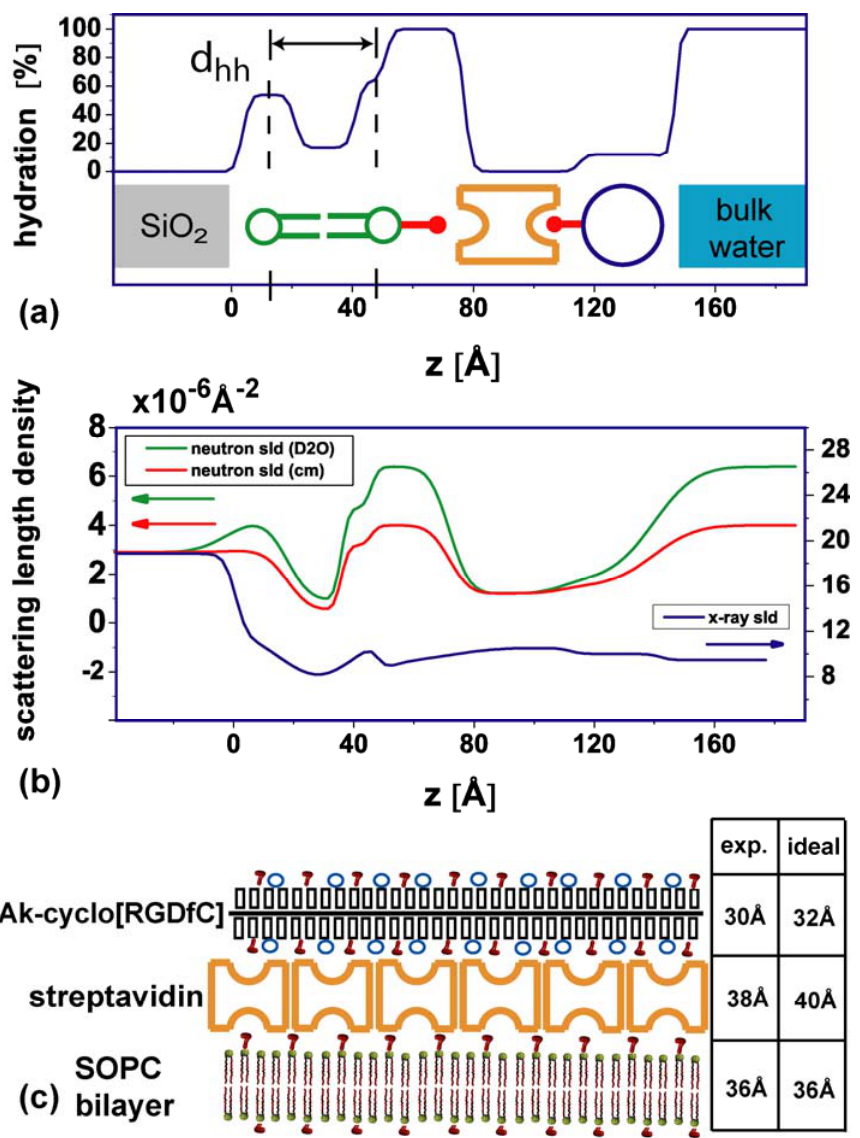
Figure 3. Scattering length density and hydration profile. ( a ) Hydration profile of the indicates the head to head layers including a schematic of the layer components. d hh distance of the lipid bilayer; ( b ) Sld profiles of layers. Colored arrows indicate the respective y-axis; ( c ) Schematic of the synthetic peptide on top of the streptavidin interlayer. Red hooks depict the biotin residues, blue circles indicate the positions of a cyclo(RGDfC) residue. The bilayer-streptavidin interlayer is omitted. The table compares experimental findings and literature